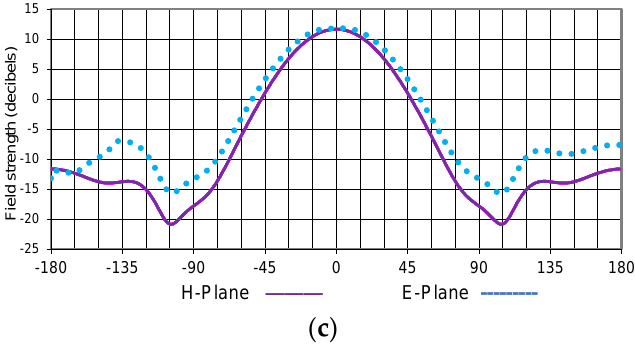
Figure 7. ( a ) Standard horn antenna. ( b ) Antenna array. ( c ) Pattern at 3 GHz, H-plane with 3 dB beam width 43.51° and E-plane pattern with 3 dB beam width 51.32°.